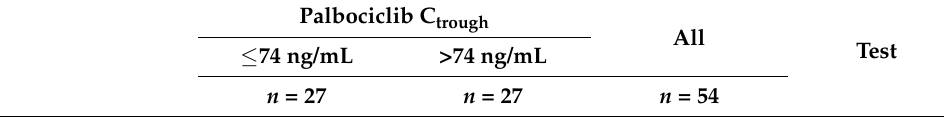
Table 3. Univariate analysis of the correlation between plasma trough concentration of palbociclib at D15C1 and selected variables. Patients evaluable for safety with usable Ctrough data ( n = 54). Palbociclib C